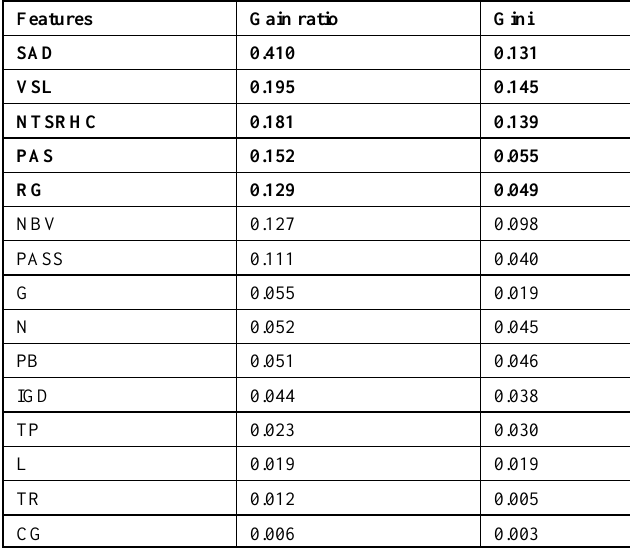
F EATURES I MPORTANCE R ANKING